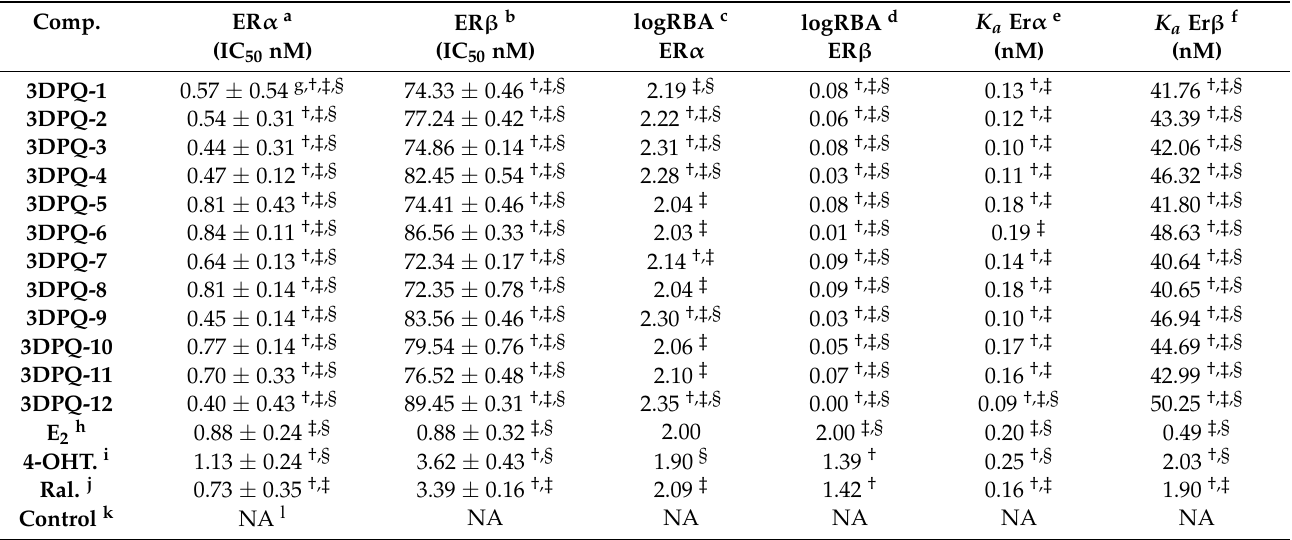
Table 7. Antagonistic potencies (IC 50 s) and the logarithm of the relative binding affinities (RBA) against ER α and ER β of the newly synthesized compounds. Isoform affinity preferences and respec- tive antagonist constants are also